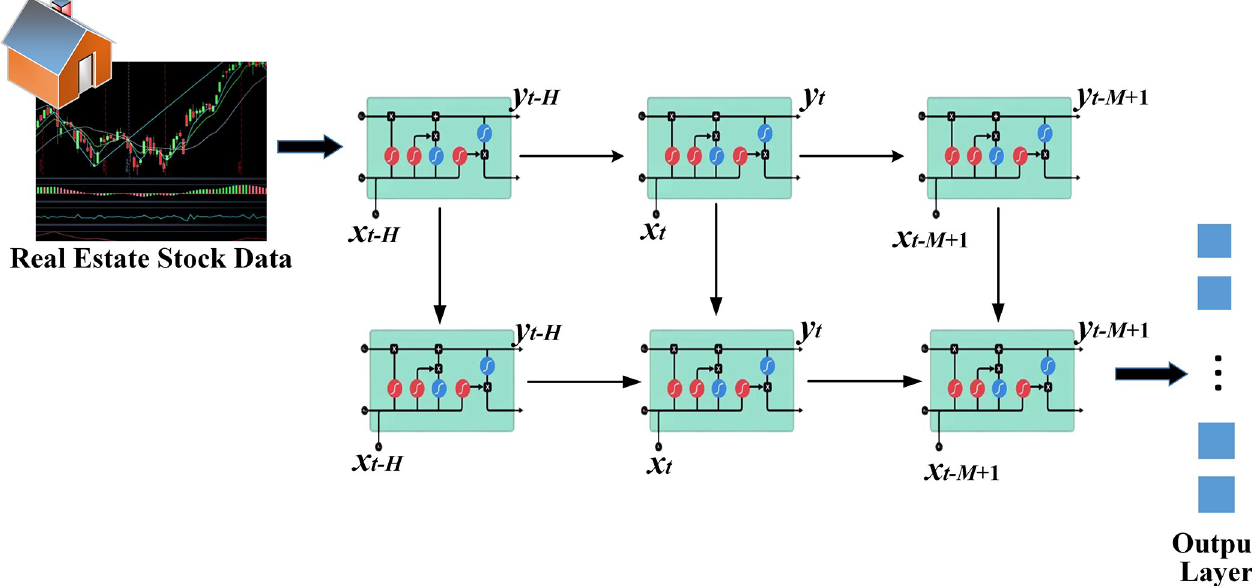
Fig 4. Schematic diagram of LSTM network applied to real estate index and stock prediction.